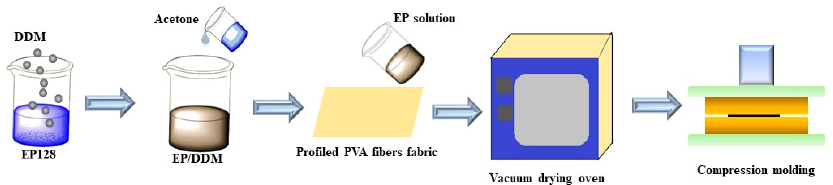
Figure 2. Preparation of PVA/EP composites.